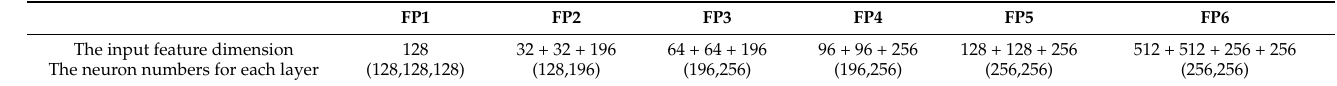
Table 2. The parameter information of the feature propagation layer where the FP1 to FP6 represent the first to sixth layers of the feature propagation layer, respectively.